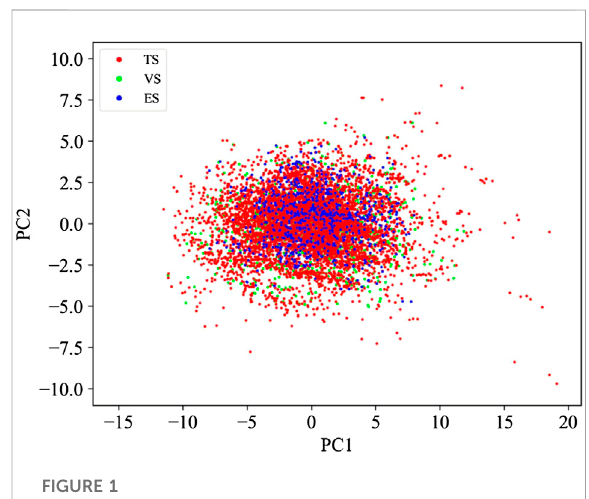
FIGURE 1 PCA based on the physicochemical properties returned by the compounds belonging to TS, VS, and